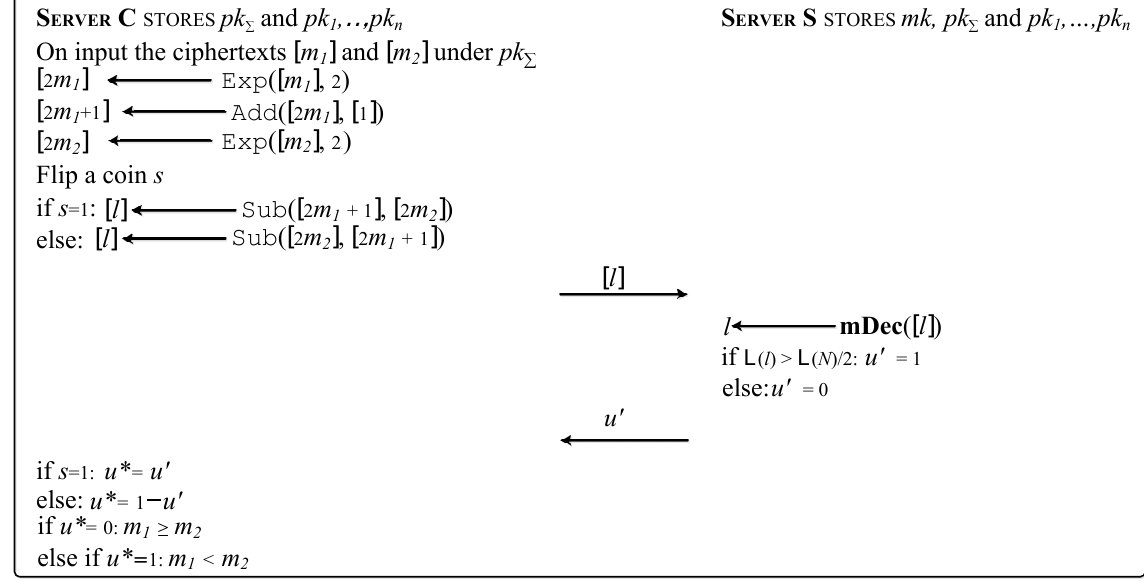
Figure A1. The LGT